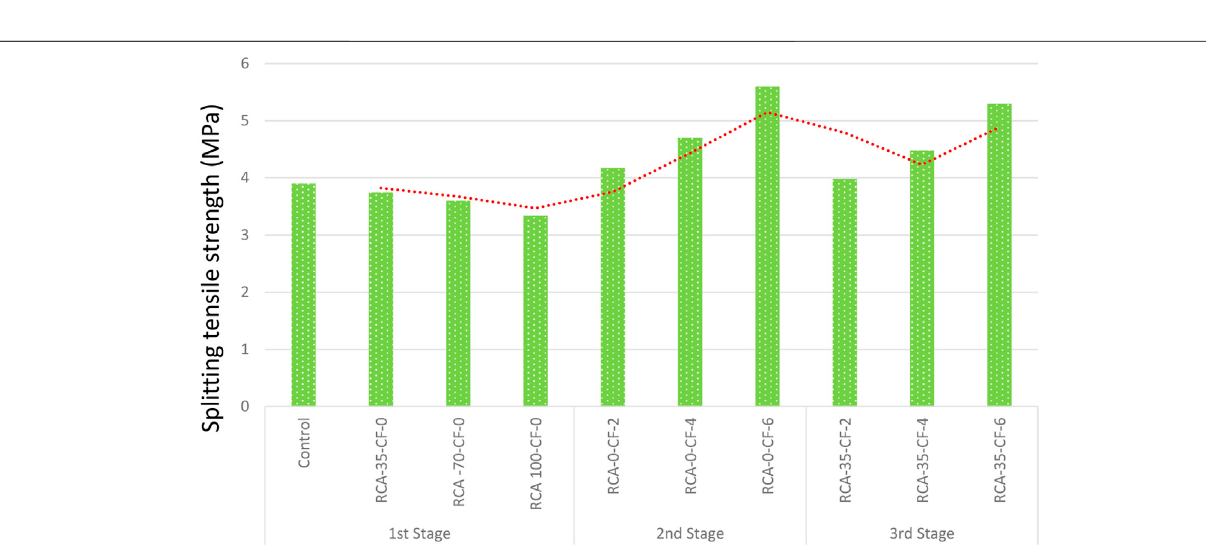
FIGURE 7 | Splitting tensile strength of all concrete samples at 28